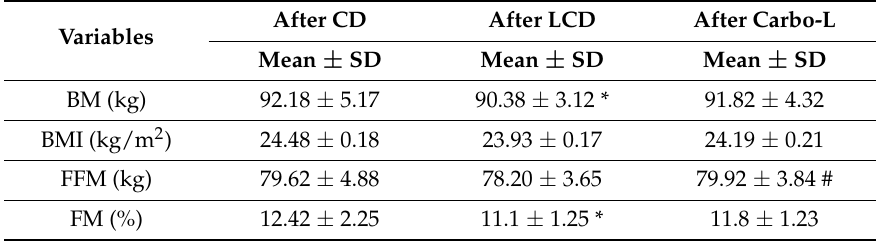
Table 1. Body mass and body composition results after CD, LCD, and Carbo-L diets.